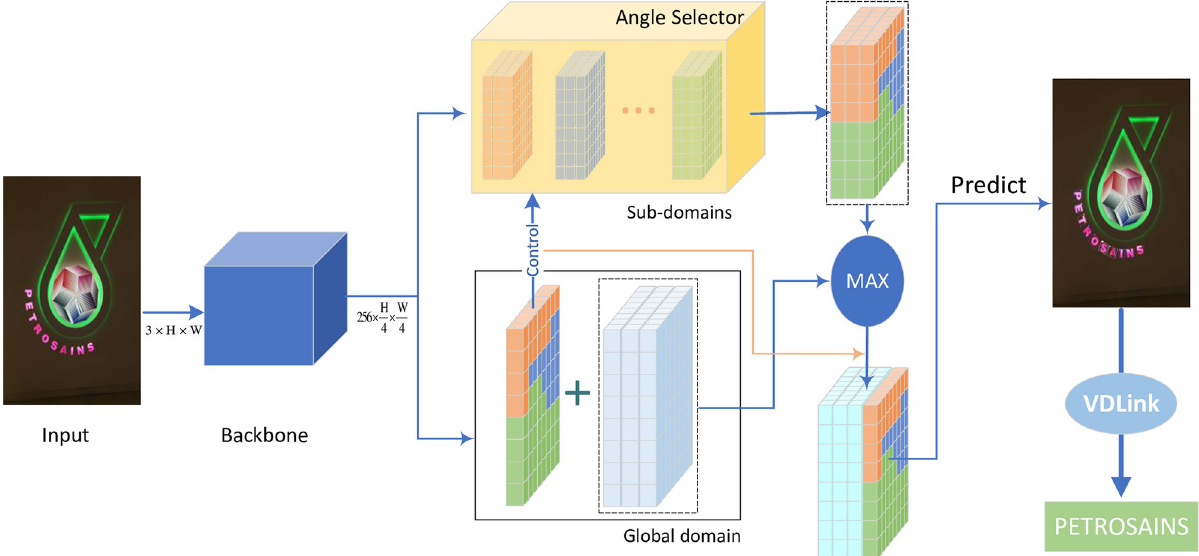
Fig 5. The framework of our proposed MA-CharNet. The global network and each sub-network share the Backbone, and use its 1/4 downsampled feature map as input. The angle selector selects the corresponding sub-network based on the angle feature map of the global network, and then further fuses this result with the output of the global network as the final output. Zoom in for better visualization. Reprinted from [19] under a CC BY license, with permission from IJDAR, original copyright 2020.